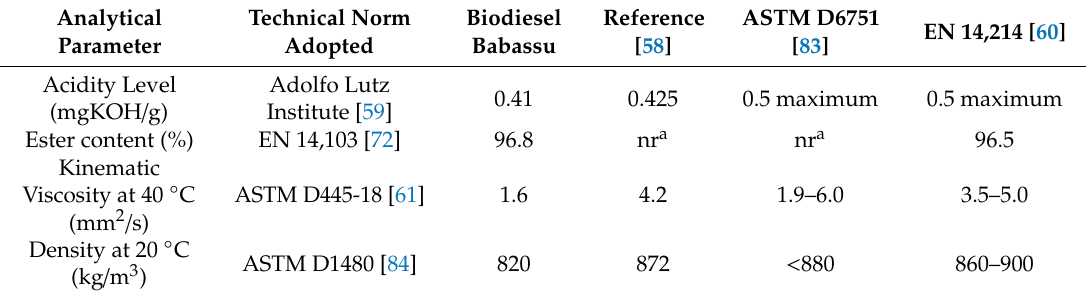
Table 6. Biodiesel properties of residual oil from babassu obtained